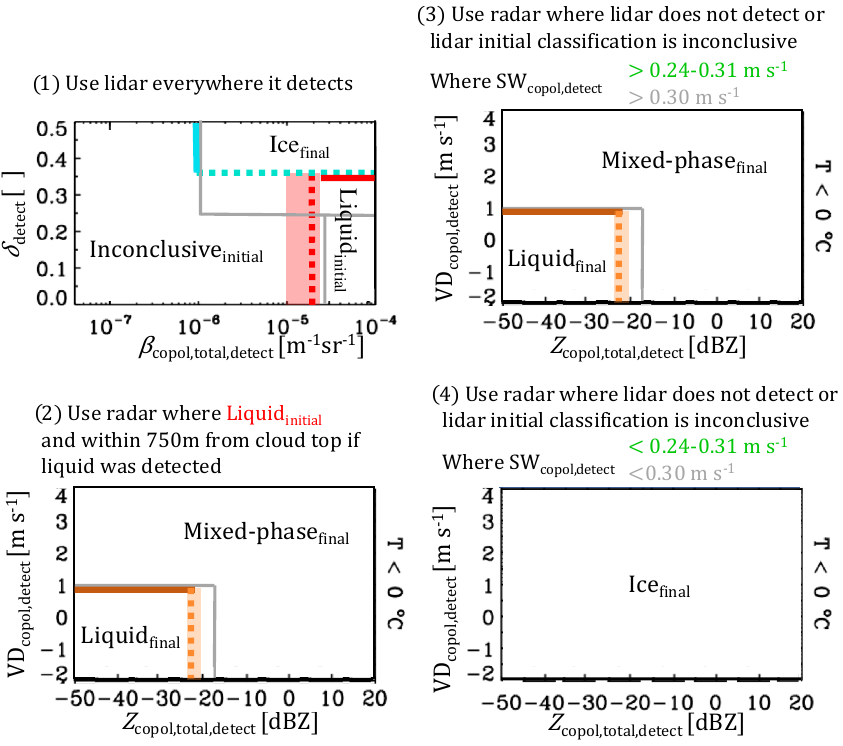
Figure 7. Collective illustration of hydrometeor-phase classification thresholds and phase-classification sequence. Fixed empirical thresholds modified from Shupe (2007) are displayed as gray lines. The objectively determined flexible thresholds are displayed using dashed colored lines and colored shading as in Fig. 6. Note that positive velocities indicate downward